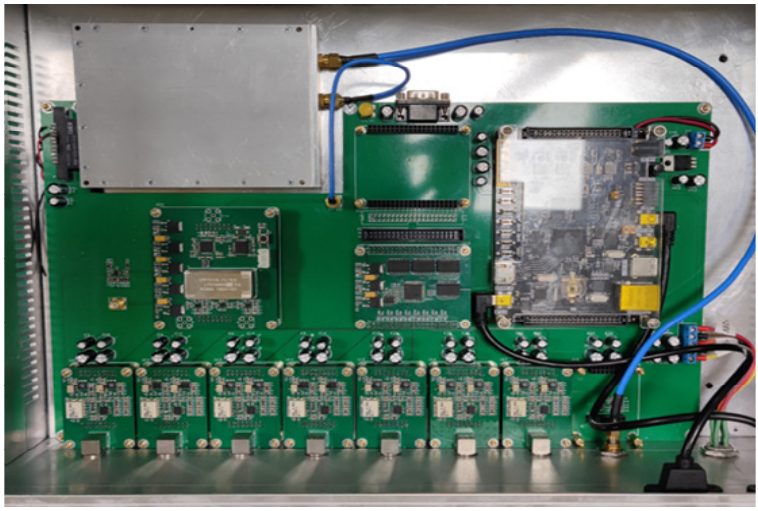
Figure 6. The structure of the multi-channel digital frequency standard comparison.